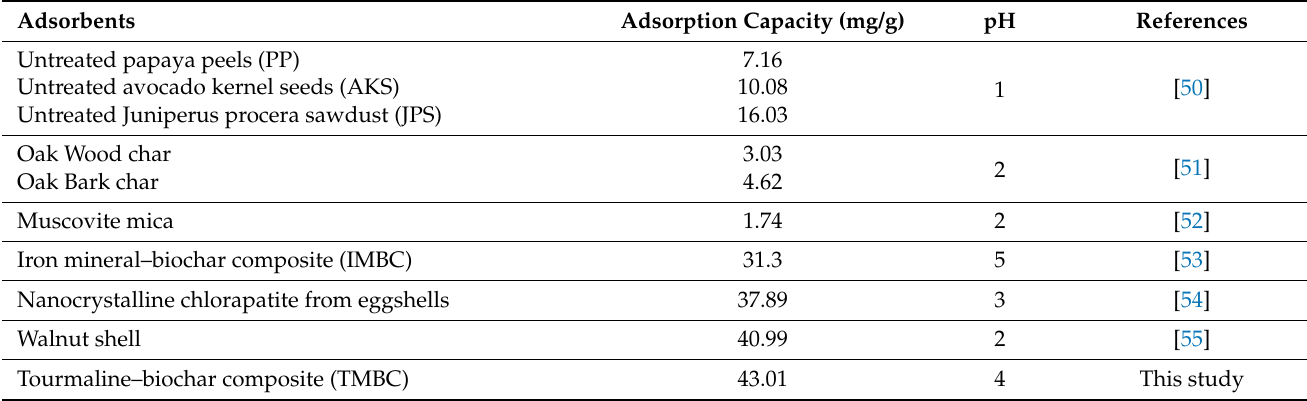
Table 4. Comparison of Cr (VI) removal by different